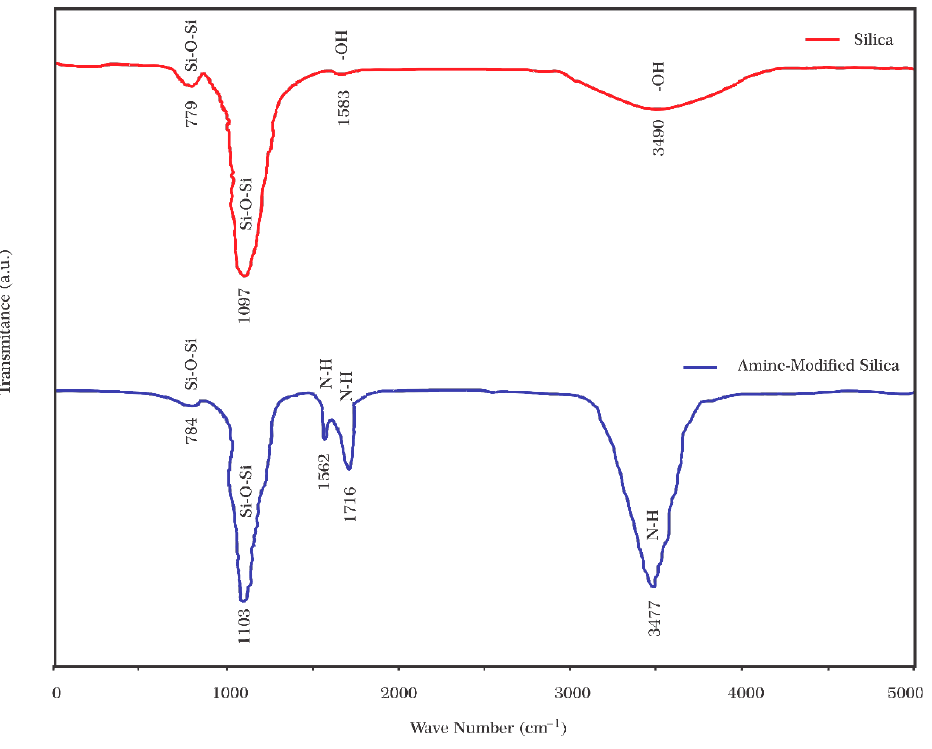
Figure 7. FT-IR spectrums of bare and amine-modified SiO 2